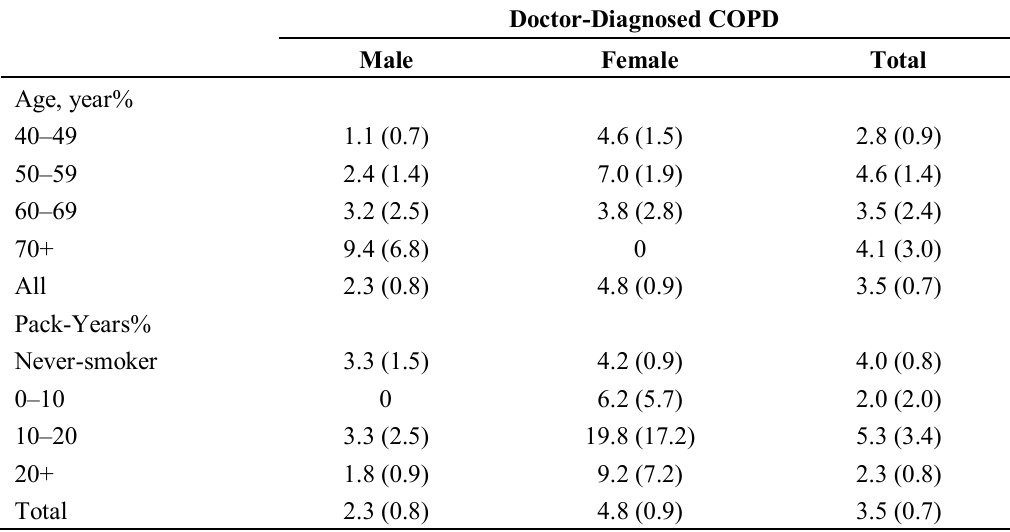
Table 4. Prevalence of COPD according to Doctor Diagnosis’s by; gender, age and pack years * .